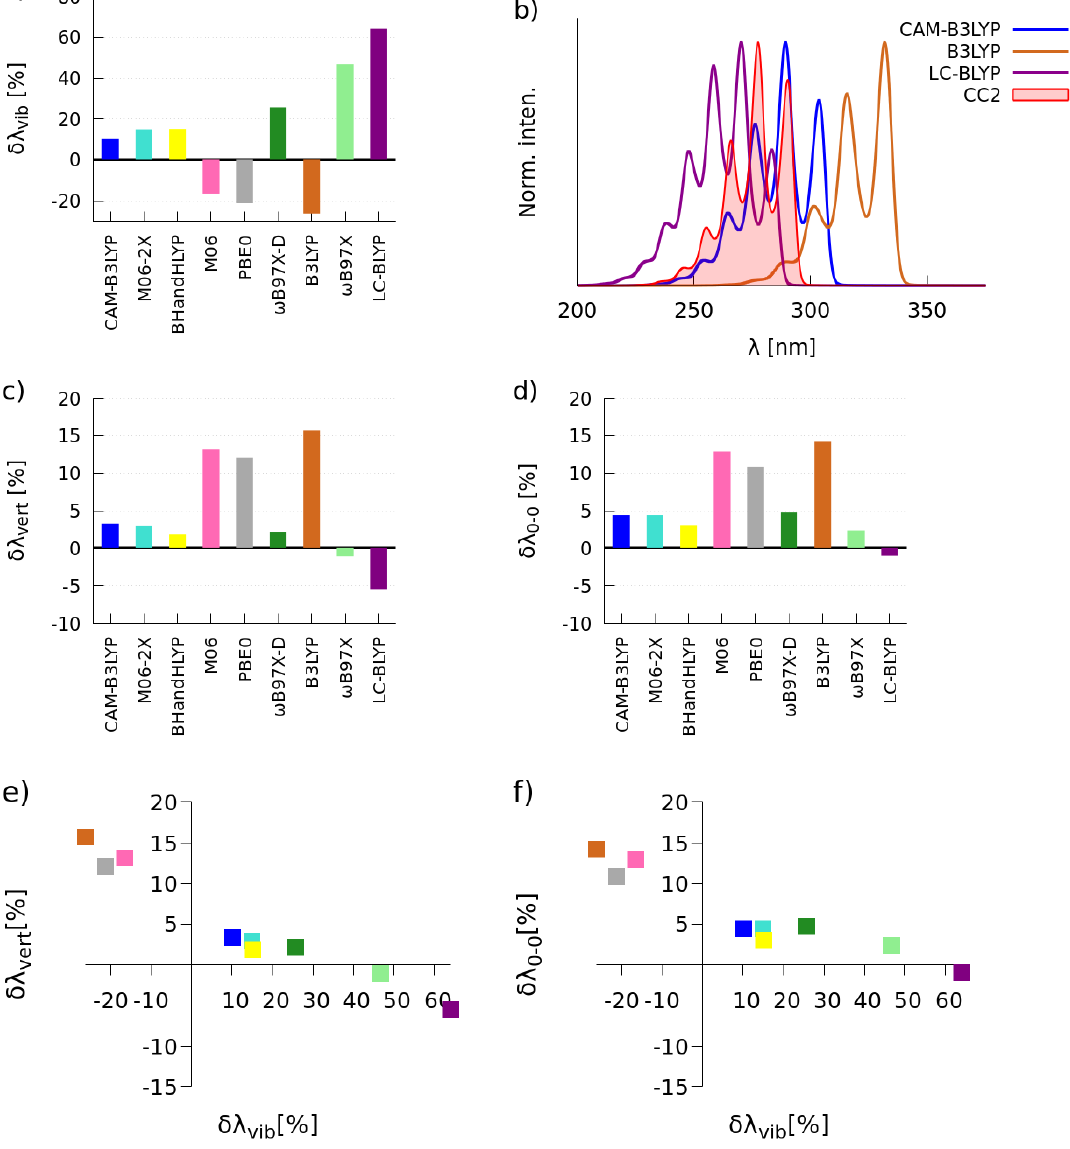
Figure 2. Bar charts showing the relative errors of λ vib ( a ), λ vert ( c ) and λ 0 − 0 ( d ) calculated with the selected XCFs with respect to the CC2 reference; the selected absorption spectra, see the text for details ( b ); graphs showing the relation of relative errors, i.e., λ vert and λ vib ( e ) and λ 0 − 0 and λ vib ( f ) for the C-1